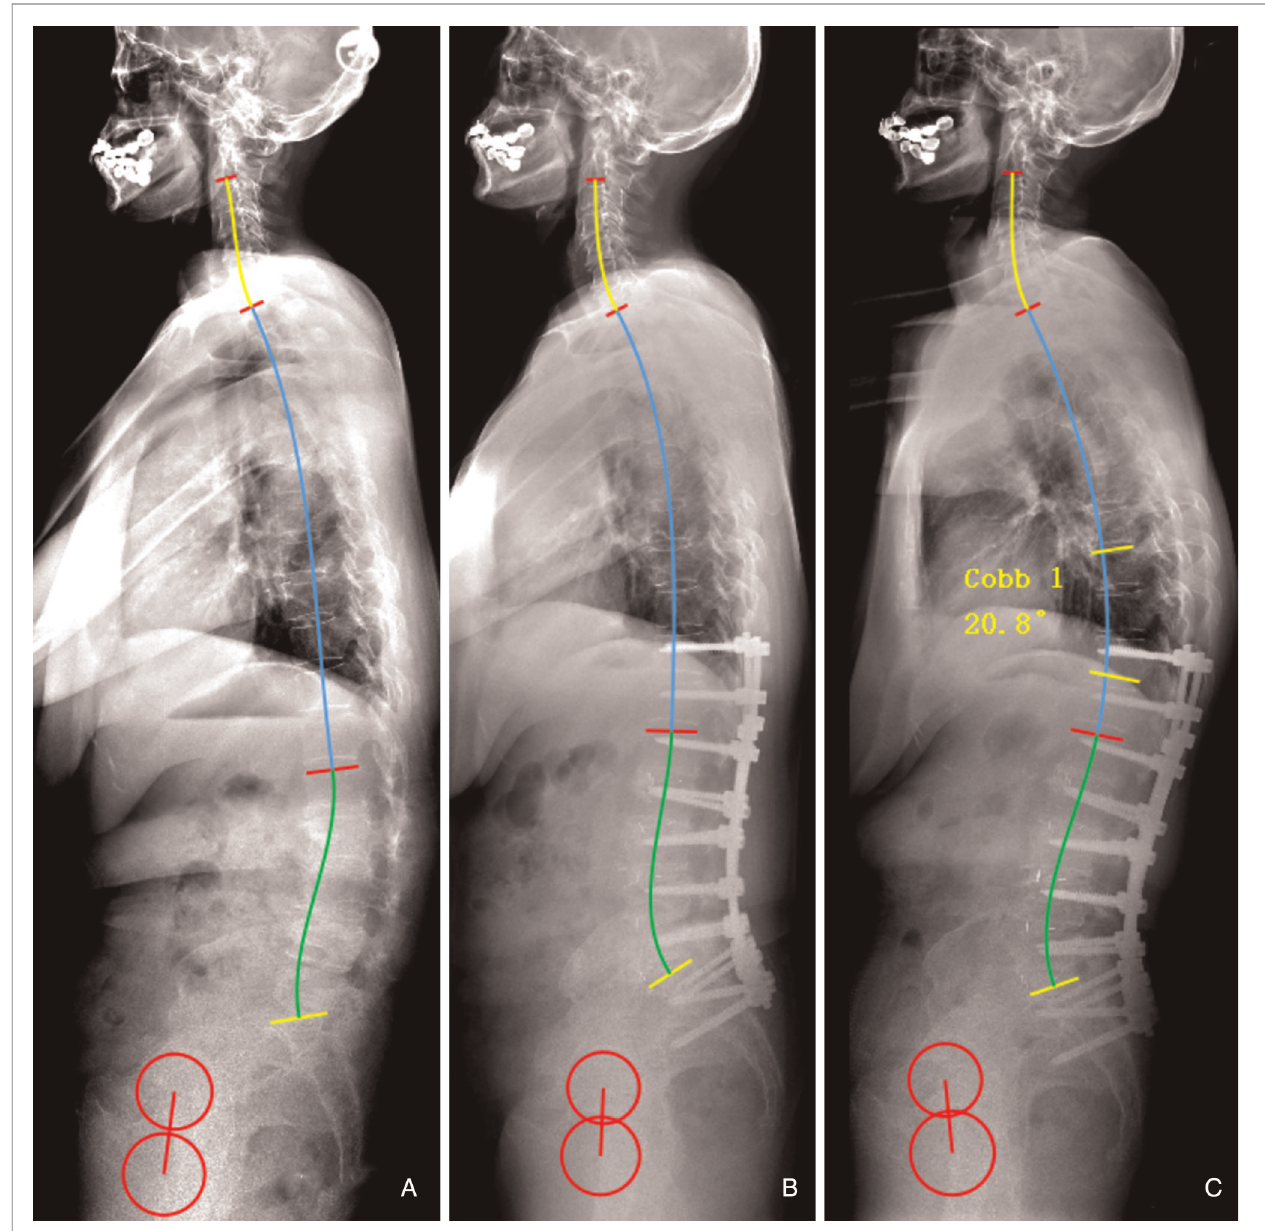
FIGURE 7 | 60-year-old female. ( A ) preoperative sagittal standing full spine X-rays, pelvic incidence (PI)=57.3°, thoracic kyphosis (TK)=4.4°, lumbar lordosis (LL)= − 2.6°. ( B ) immediate postoperative X-rays, pelvic incidence=57.7°, thoracic kyphosis=23.8°, lumbar lordosis (LL)= − 34.6°; ideal LL=0.7*57.7+0.4*23.8+1= − 50.9°, Δ LL=34.6 – 50.9=16.3°. ( C ) PJK occurred at 2-year